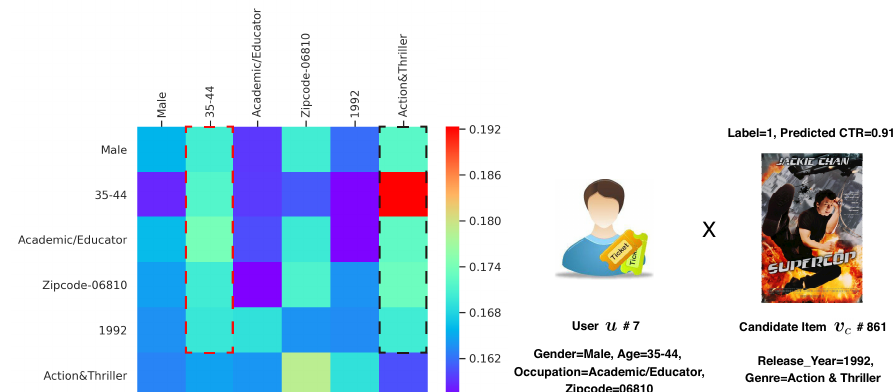
Figure 4. A heat map of attention weights for feature interactions on MovieLens-1M. The axes represent attribute fields of u and v c (gender, age, occupation, zipcode, movie’s release year, genre). Influential feature interactions are highlighted with bright colors (Label = 1, Predicted CTR =